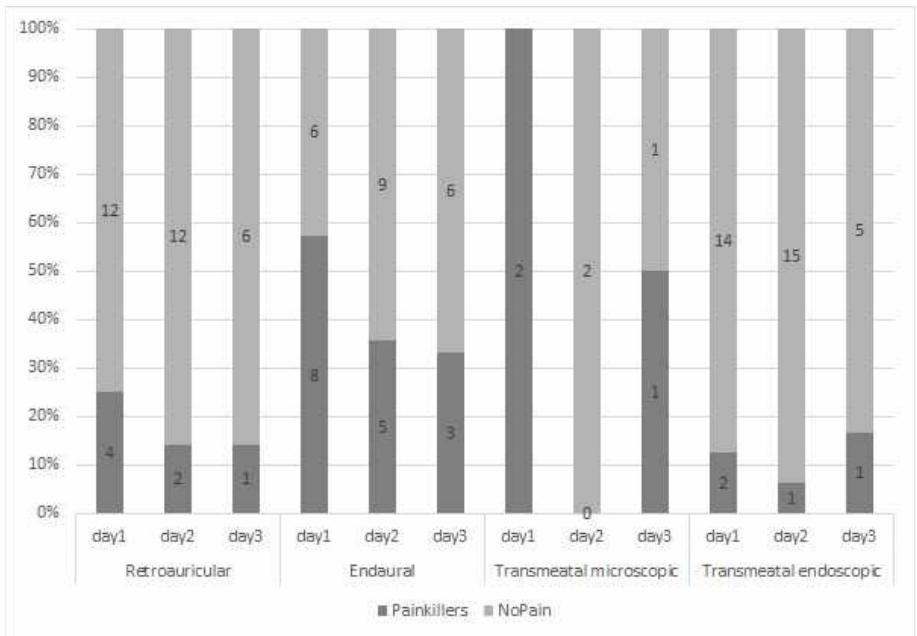
Fig. 5. A consumption of analgetics after endoscopic and microscopic ear surgeries in the choles- teatoma group only. The graph reports the number of patients taking any painkiller versus patients not requiring any pain